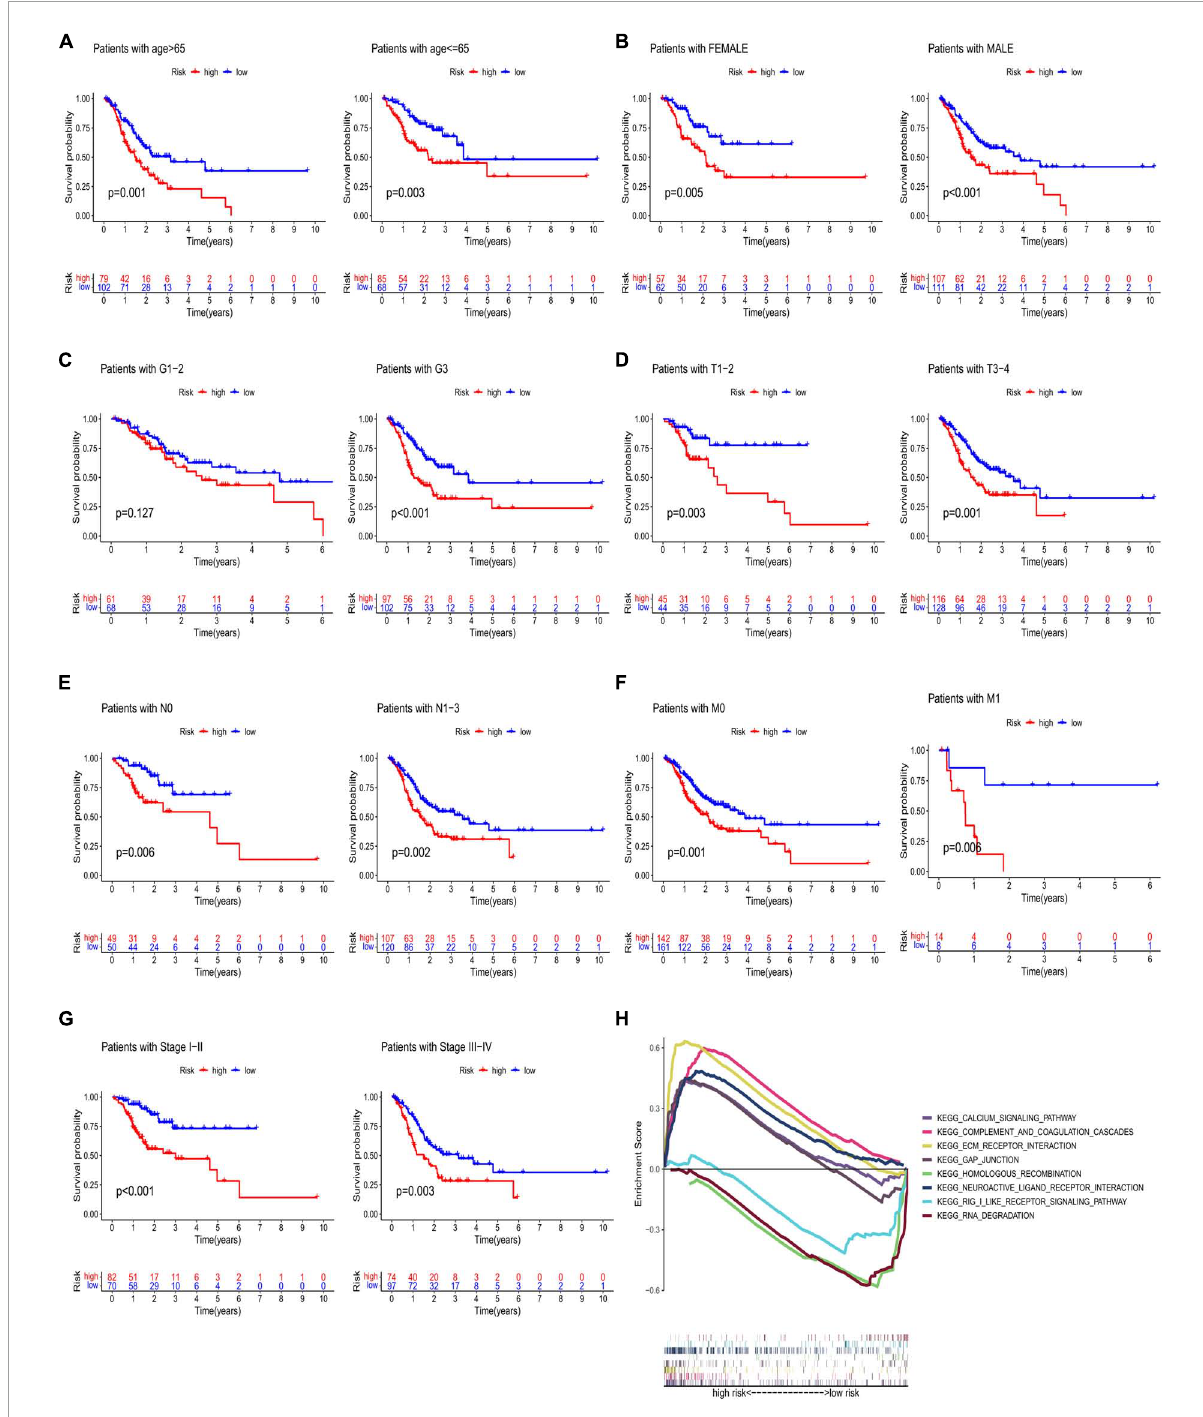
FIGURE4 Kaplan–Meier analyses of age (A) , gender (B) , grade (C) , T stage (D) , N stage (E) , M stage (F) , and stage (G) . (H) GSEA of low- and high-risk groups. GSEA, gene set enrichment analysis.